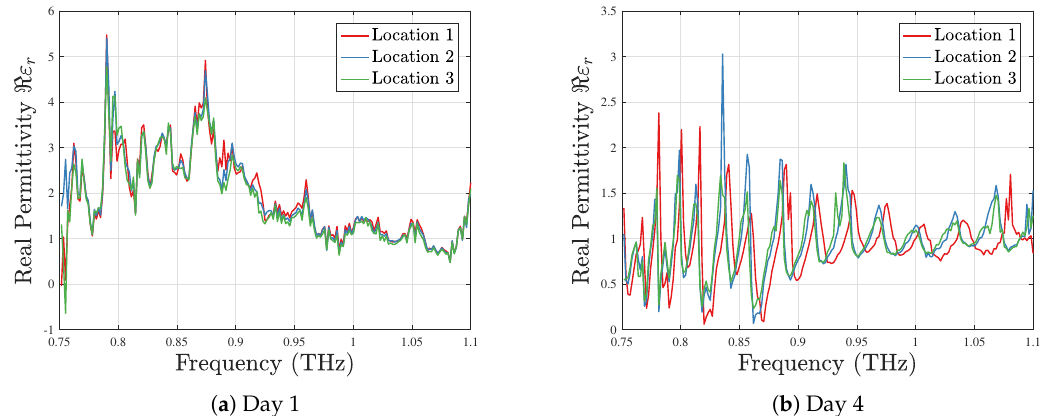
Figure 3. Real part of permittivity of coffea leaves at three different locations taken on days 1 and